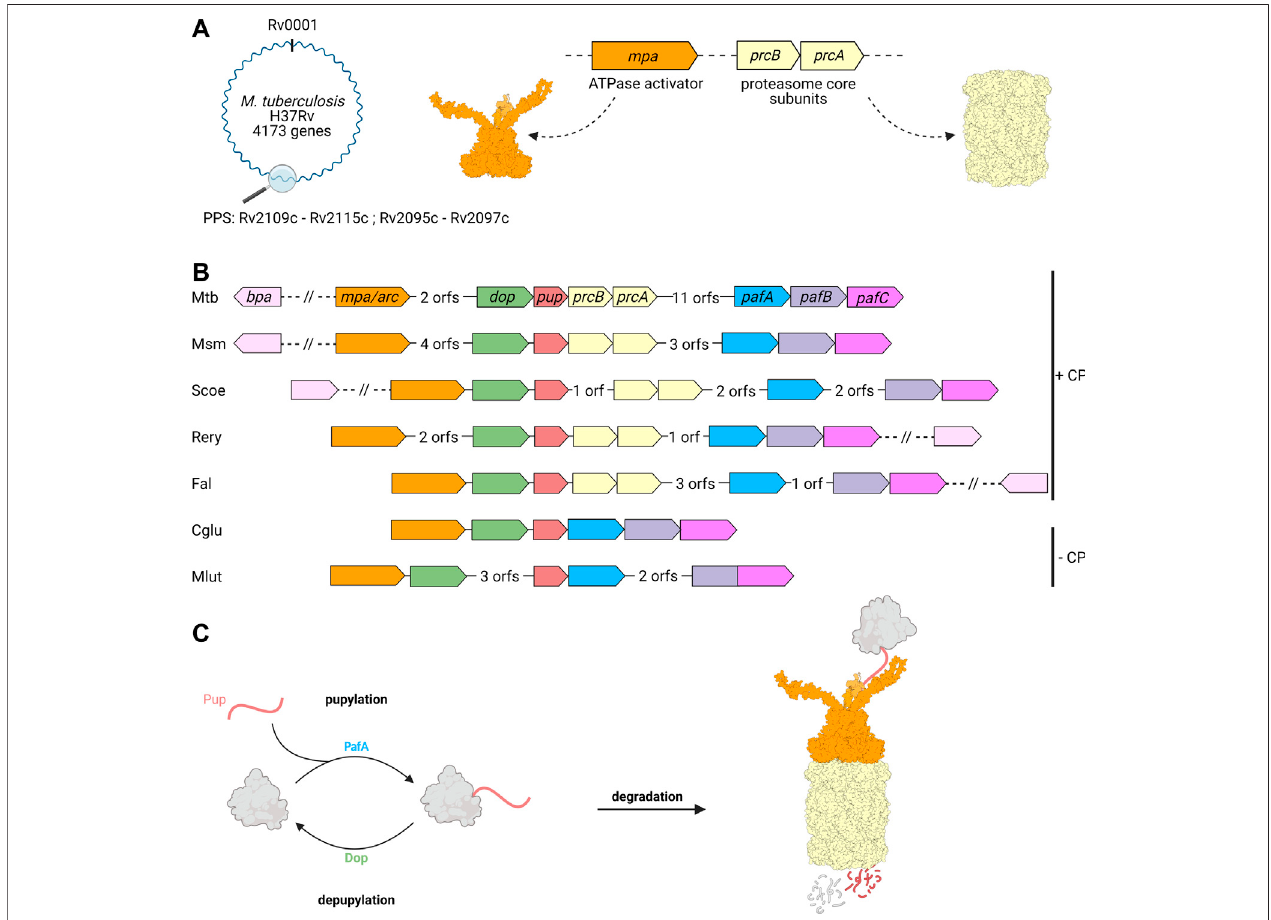
FIGURE 2 | Genes involved in pupylation and Pup-dependent proteasomal degradation are organized in the Pup-proteasome gene locus in Actinobacteria. (A) Members of the Pup-proteasome system (PPS) are encoded in close proximity to one another in the PPS gene locus, ranging from Rv2109c to Rv 2097c in Mtb. The genes coding for the hexameric ATPase Mpa (Rv2115c, orange) and proteasomal α and β subunits PrcA and PrcB (Rv2109 and Rv2110c, beige), were most likely acquiredbyhorizontalgenetransfer. (B) InadditiontoMpa/ARCandthe20Sproteasomalsubunits,thePPSgenelocusalsoencodestheubiquitin-likeproteinPup (Rv2111c,red), the Pup-ligase PafA (Rv2097c, blue),and the depupylase Dop (Rv2112c, green). The transcriptional regulator PafBC (Rv 2096c and Rv 2095c, purple), is found in close proximity to PafA and has been shown to regulate the major DNA damage response in mycobacteria, to which the PPS is tightly linked. The alternative ring shaped ATP- and pupylation-independent activator Bpa (Rv3780, light pink) is not found in the Pup-Proteasome gene locus, but strictly co-occurs with the proteasomal subunit genes across Actinobacteria. A subgroup of Actinobacteria is missing the proteasomal subunit genes in their PPS locus, likely by secondary loss during evolution. Mtb, Mycobacterium tuberculosis ; Msm, Mycobacterium smegmatis ; Scoe, Streptomyces coelicolor ; Rery, Rhodococcus erythropolis ; Fal, Frankia alni ;Cglu, Corynebacteriumglutamicum ;Mlut, Micrococcusluteus . (C) Pupylationinvolvesthepost-translationalmodi fi cationoftargetproteins(grey)withPup(red),and iscatalyzedbythePupligasePafA.PupylatedproteinsareeitherdepupylatedbythedeamidaseDoporrecruitedtotheMpa-20Sproteasomecomplexforunfoldingand